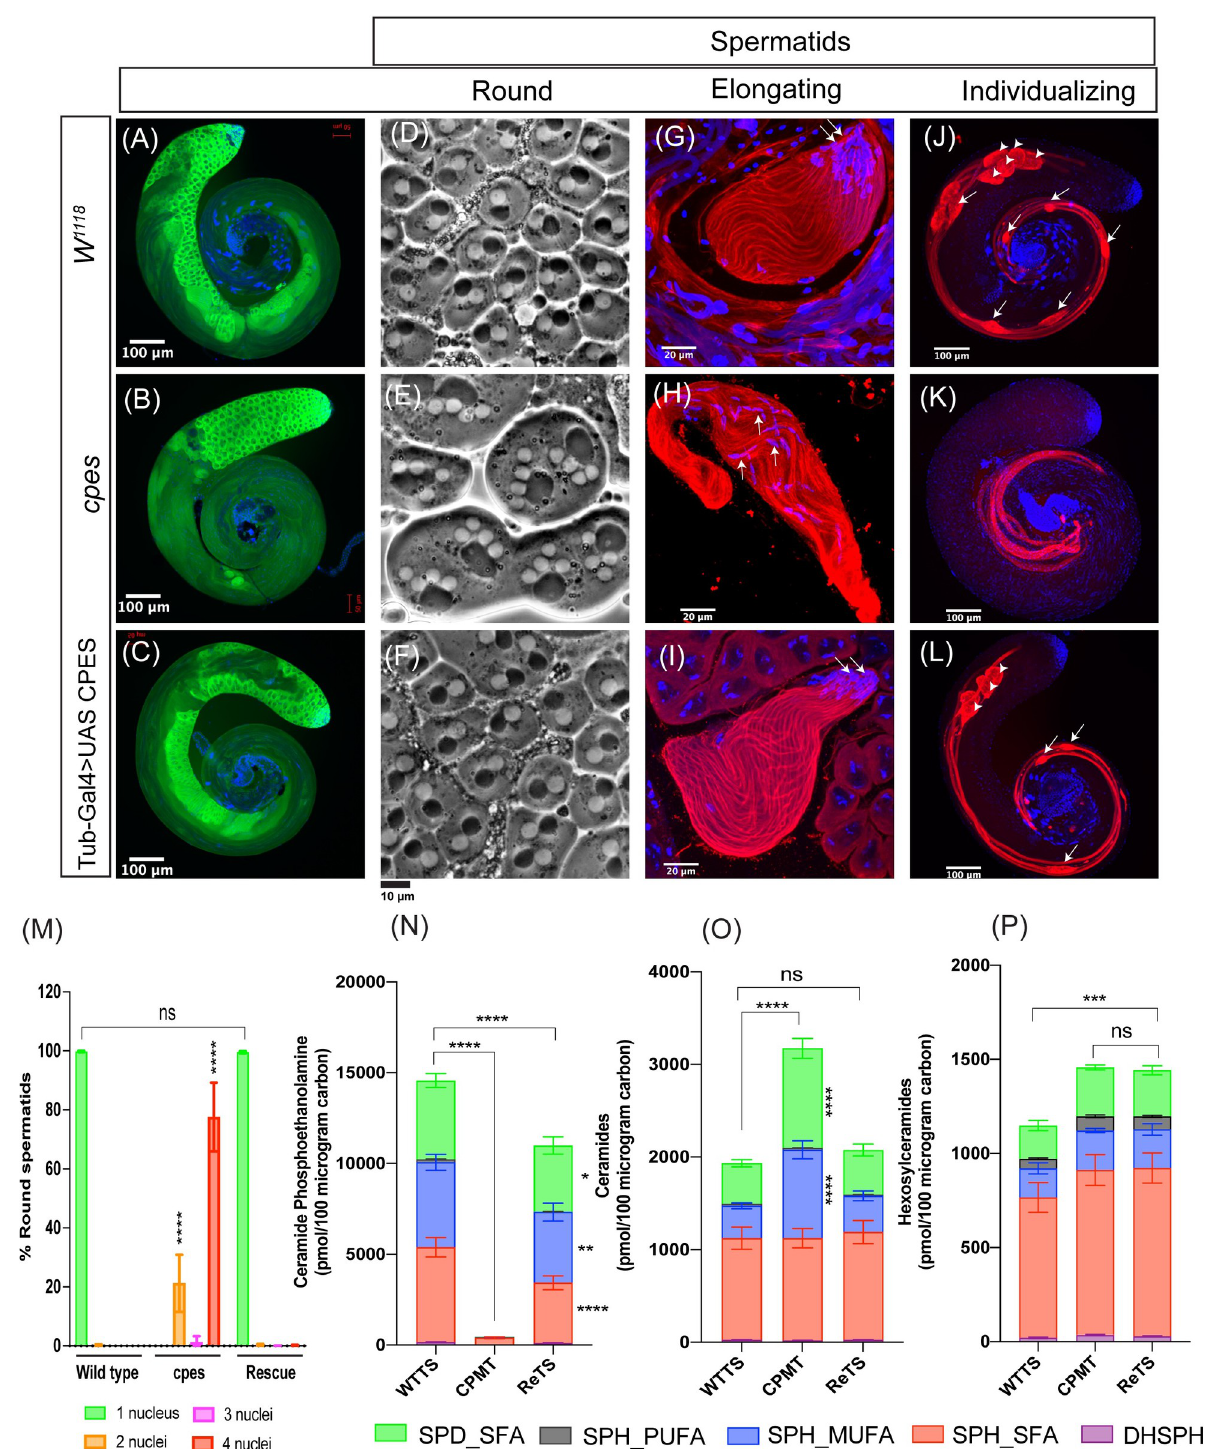
Fig 2. Cytological, immunofluorescence, and sphingolipid analyses in cpes mutants. (A–C) Whole mount of Drosophila testis immunostained for germ cell-specific Vasa protein primary antibody and Alexa Fluor 488 secondary antibody (green) and DNA with DAPI (blue) to visualize various stages of germ cells including stem cells, spermatogonia, and spermatocytes (A) w 1118 , (B) cpes mutant, and (C) Tub-Gal4 > UAS-CPES rescue. (D–F) Phase contrast microscopy of live testis squash preparations to visualize round/onion stage spermatids (D) w 1118 , (E) cpes mutant, and (F) Tub- Gal4 > UAS-CPES rescue. (G–I) Testis squash preparation followed by fixation and immunostaining to visualize early elongating spermatids. Arrow